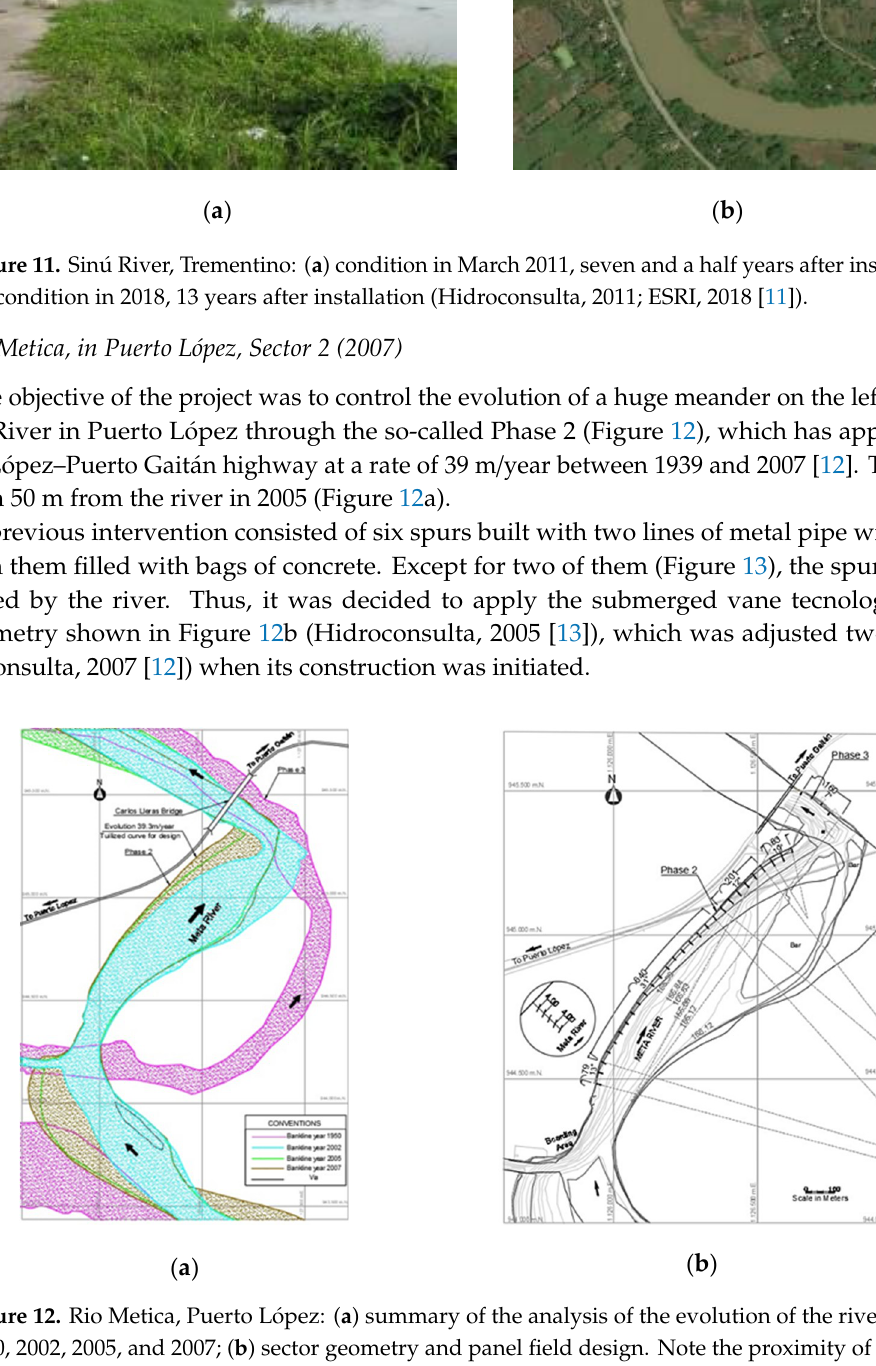
Figure 10. Sinú River, Trementino: ( a ) at the beginning of the panel installation in September 2003; ( b ) condition in August 2006, three years later (Hidroconsulta, 2003; 2006).